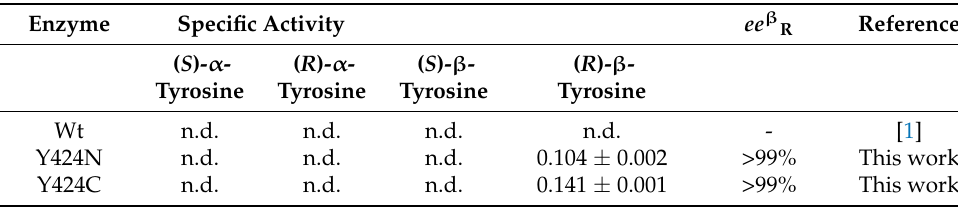
Table 2. Comparison of the specific activity and enantiomeric excess of wild type and mutants Tyr424Asn and Tyr424Cys in the ammonia addition